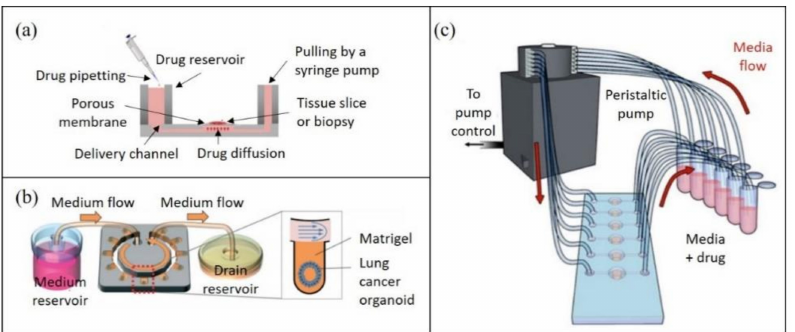
Figure 4. Representative tumor-on-chip platforms for potential applications in personalized medicine: ( a ) cross-sectional representation of a tumor tissue slice cultured on a porous membrane (adapted from [21]); ( b ) cartoon depiction of a microfluidic yarn flow resistor passive microflow device for human lung organoid development and culture (adapted from [89]); ( c ) schematic depiction of a microfluidic device plug-in loop to enable cell media delivery to cultured spheroids from a reservoir using a peristaltic pump (adapted from